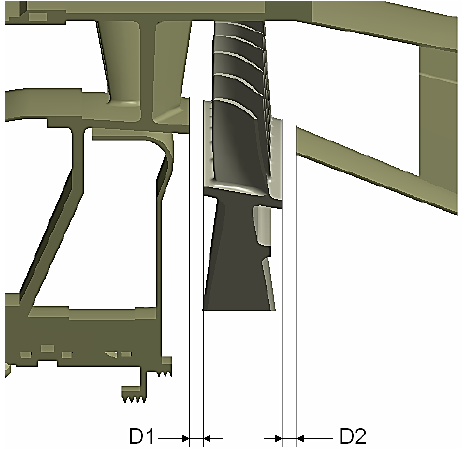
Figure 17. Illustration of the clearances between the turbine disc and the static components.